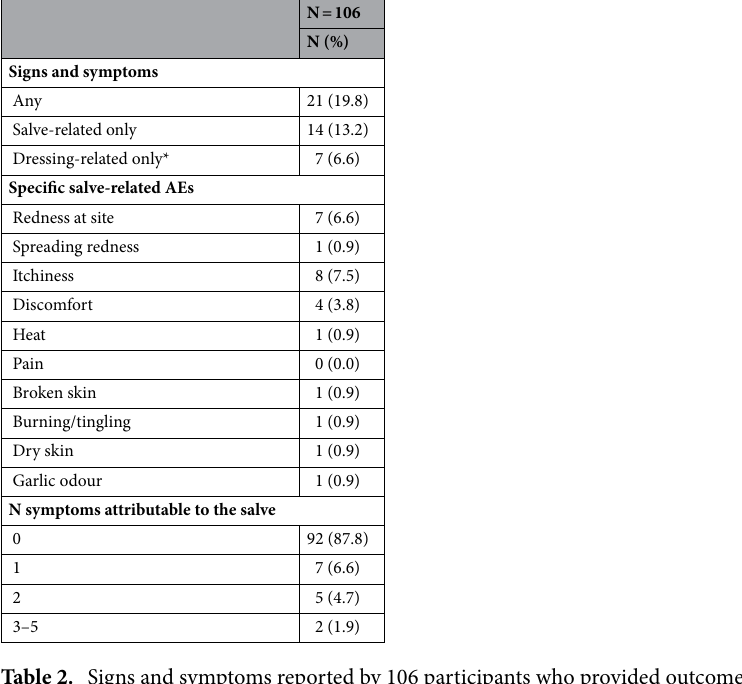
Table 2. Signs and symptoms reported by 106 participants who provided outcome data at 48